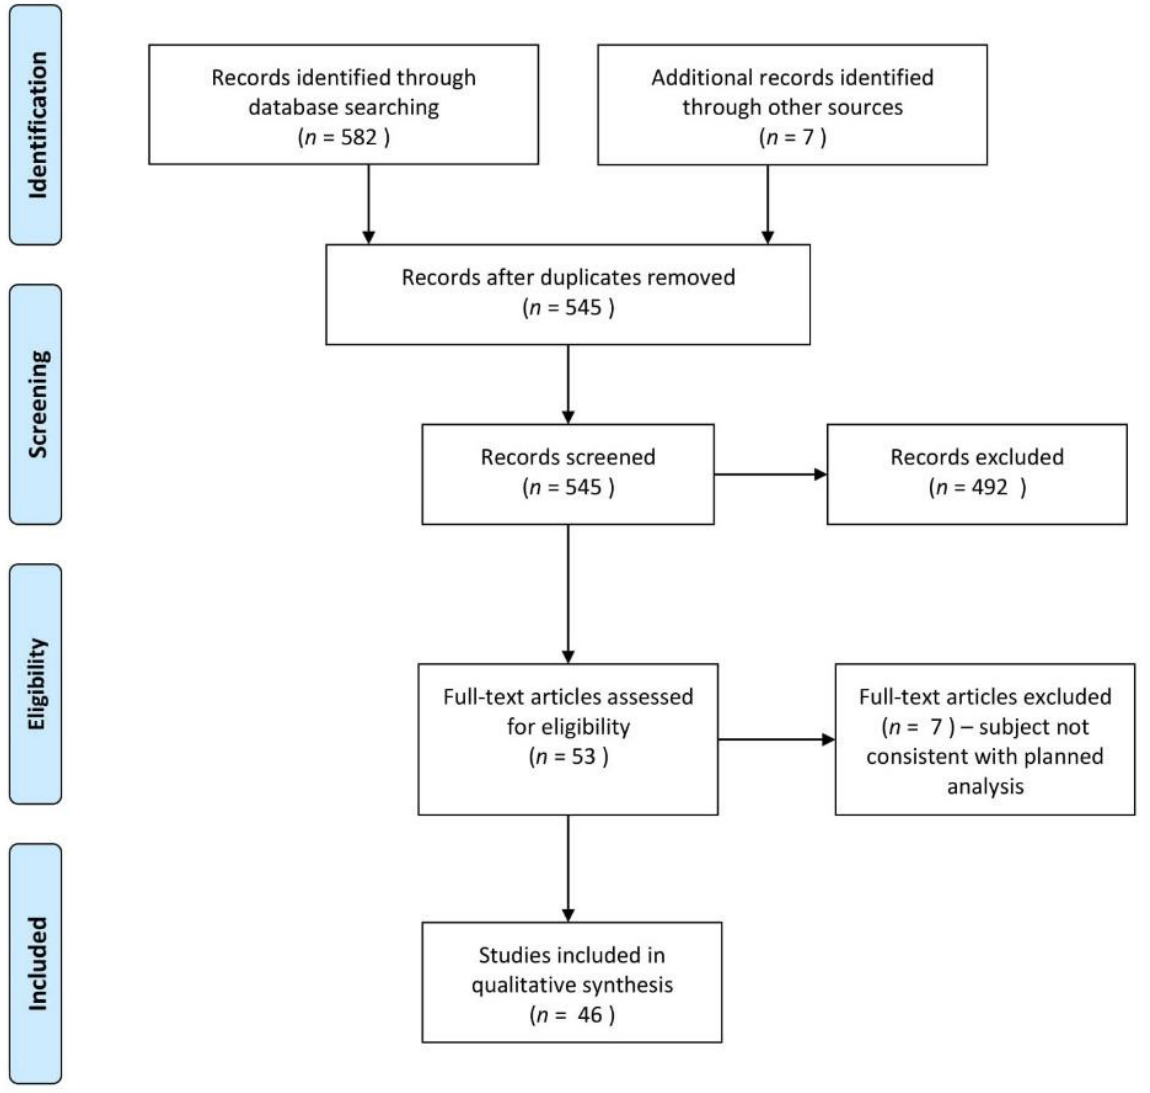
Figure 1. Search strategy and